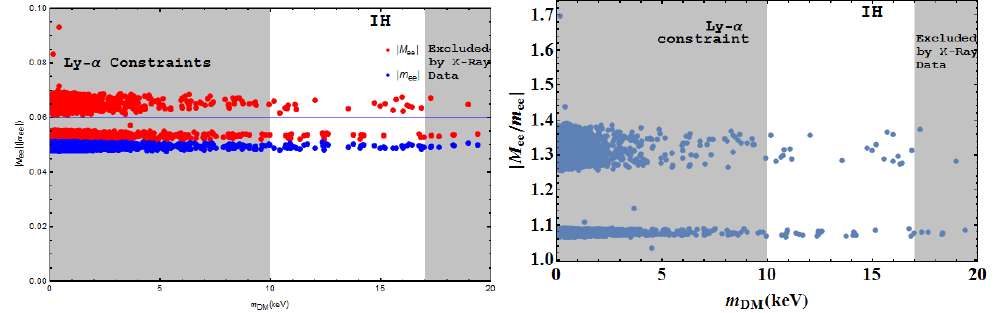
Figure 17 . E(cid:11)ective mass as a function of m DM for inverted hierarchy.The standard contribution is shown in blue color and nonstandard contributions with pseudo-Dirac neutrinos and sterile state are shown in red color. Comparison of these two contributions are shown in the (cid:12)gure on the right side.